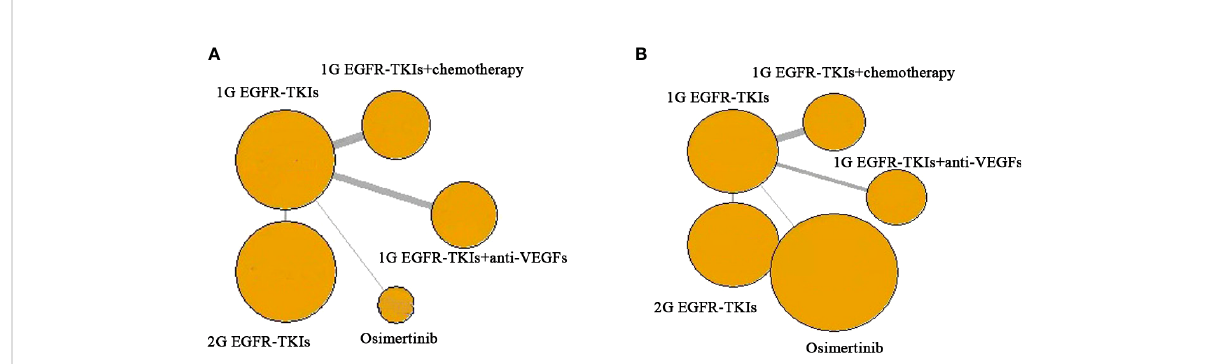
FIGURE 2 Network of the comparisons for the network meta-analysis. (A) PFS; (B) OS. Each circular node represents a type of treatment. The circle size is proportional to the total number of studies. The width of lines is proportional to the number of studies performing a head-to-head comparison in the same study. Abbreviations: First-generation EGFR-TKIs (1G EGFR-TKIs); Second-generation EGFR-TKIs (2G EGFR-TKIs); anti-vascular endothelial growth factors drugs